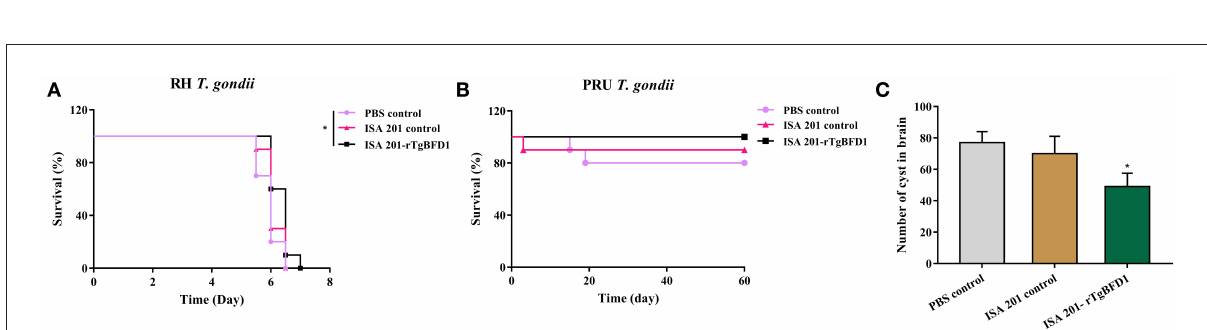
FIGURE6 Mice survival time analyses and brain cyst number statistics. (A) Mice survival time analyses in T. gondii RH strain infection assay. Data were analyzed by the Kaplan–Meier method. (B) Mice survival times analyses in the T. gondii PRU strain infection assay. The survival of PRU strain-infected mice was observed for a 60-day period. Data were analyzed by the Kaplan–Meier method. * p < 0.05 vs. PBS control group. (C) Brain cyst number statistics of mice challenged with the T. gondii PRU strain. Data were presented as mean ± SEM and analyzed by a one-way ANOVA. * p < 0.05 vs. PBS control